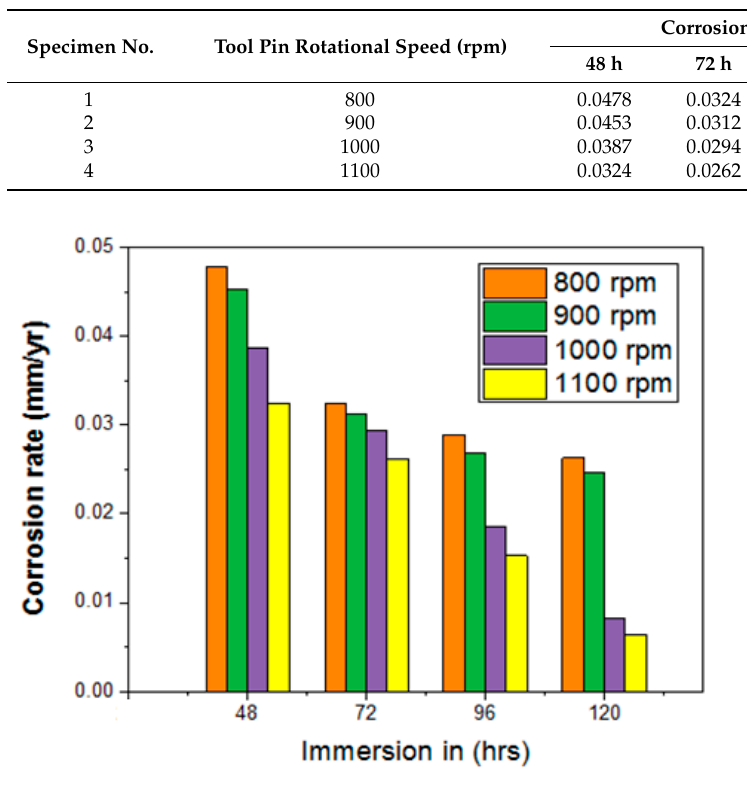
Figure 8. Corrosion test graph, immersion vs. corrosion rate.